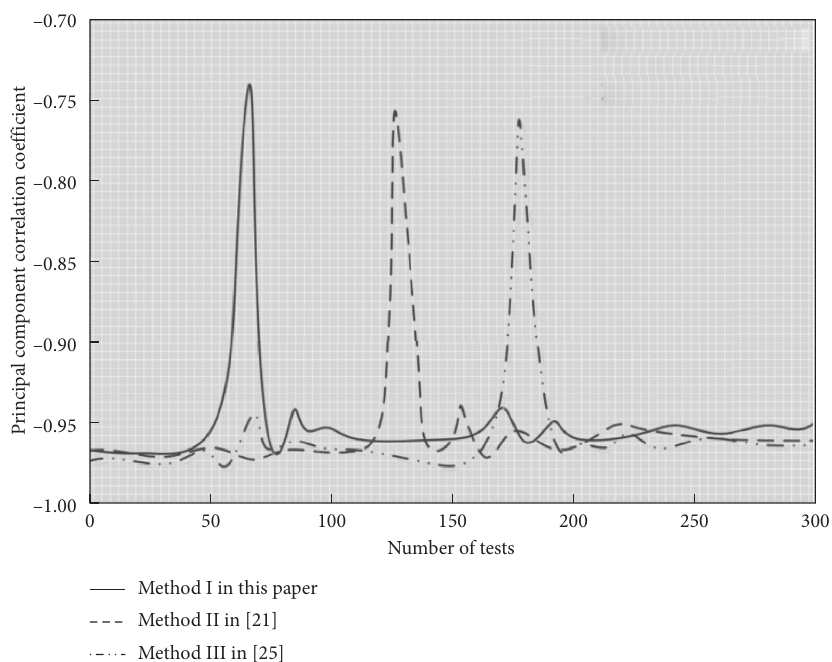
Figure 5: The principal component correlation coefficients calculated by methods I, II, and III.